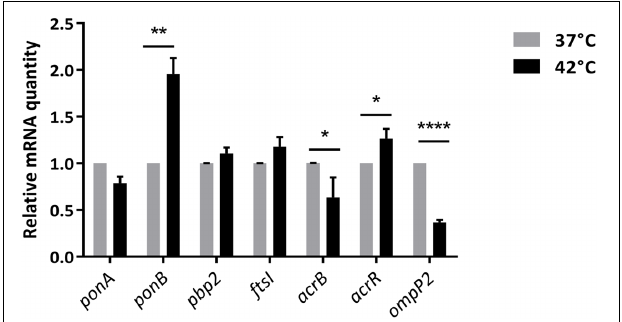
FIGURE 7 | qRT-PCR of differentially expressed genes. The mRNA levels of target genes were normalized based on their ribosomal RNA small subunit methyltransferase H (RsmH) transcript level, which were assayed in each round of qRT-PCR. Data were presented as means ± SD of 4 independent biological replicates. ∗ p < 0.05, ∗∗ p < 0.01, ∗∗∗ p < 0.001, ∗∗∗∗ p < 0.0001 (paired Student’s t -test).